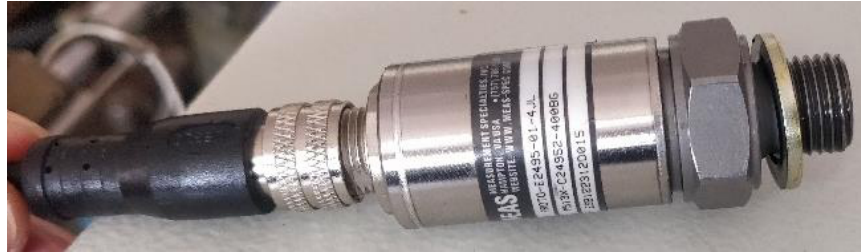
Figure 7. The pressure sensor.